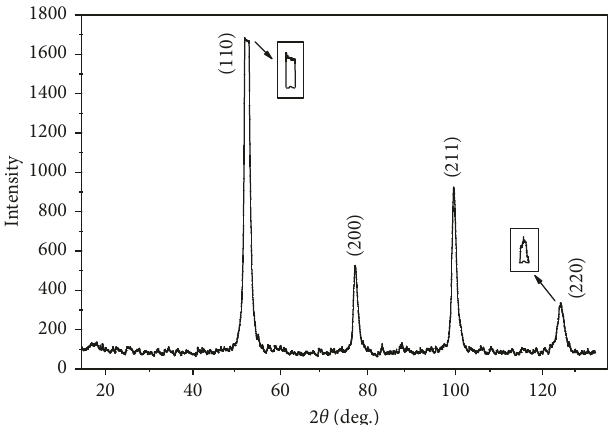
Figure 3: The diffractogram of 40Kh steel after the V SO at a depth of 100 μ m.